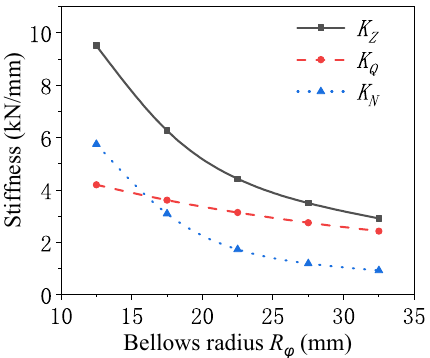
Figure 6. Schematic diagram of the stiffness of the air spring varying with the bellows radius.